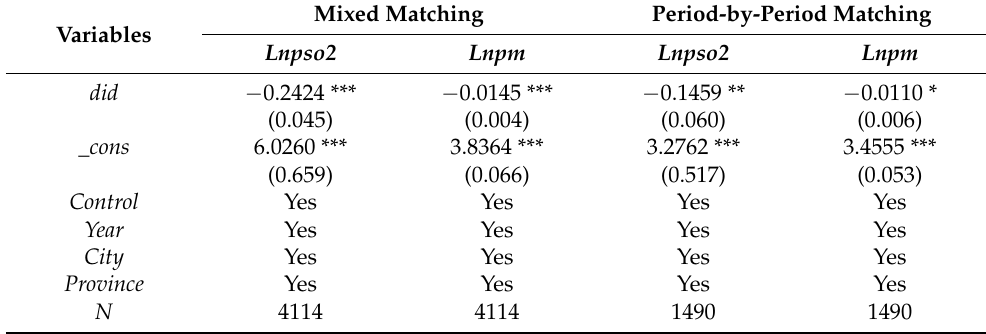
Table 3. PSM-DID regression results.